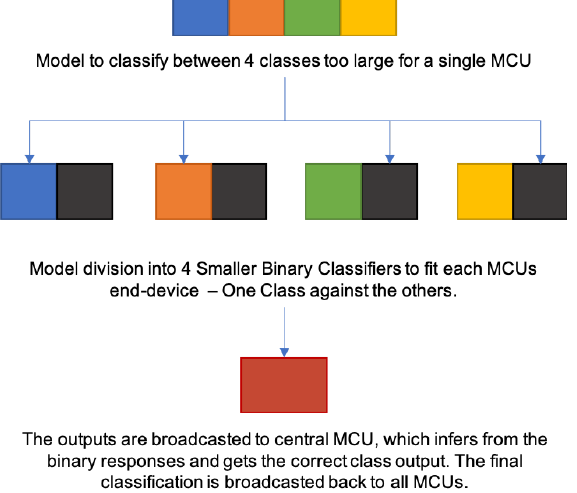
Figure 7. Model mesh.